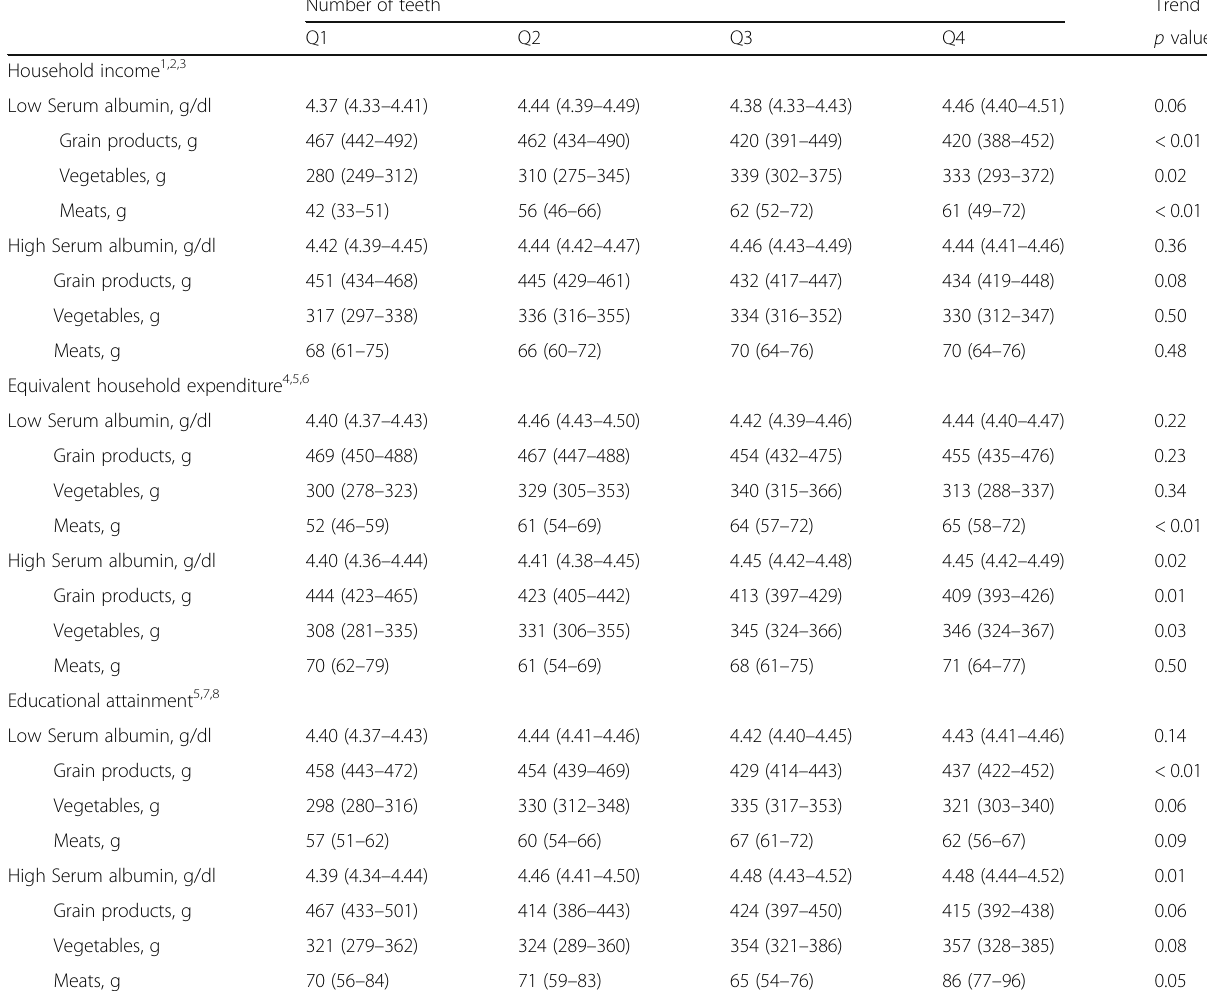
Table 5 Adjusted means of selected factors according to socioeconomic status (brackets contain 95% confidence intervals) Number of teeth